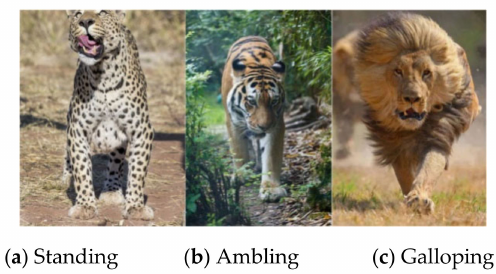
Figure 6. Images in which felines’ spines are perpendicular to the image plane in space: from this perspective, the angle of leg joints is almost straight regardless of species and the states of